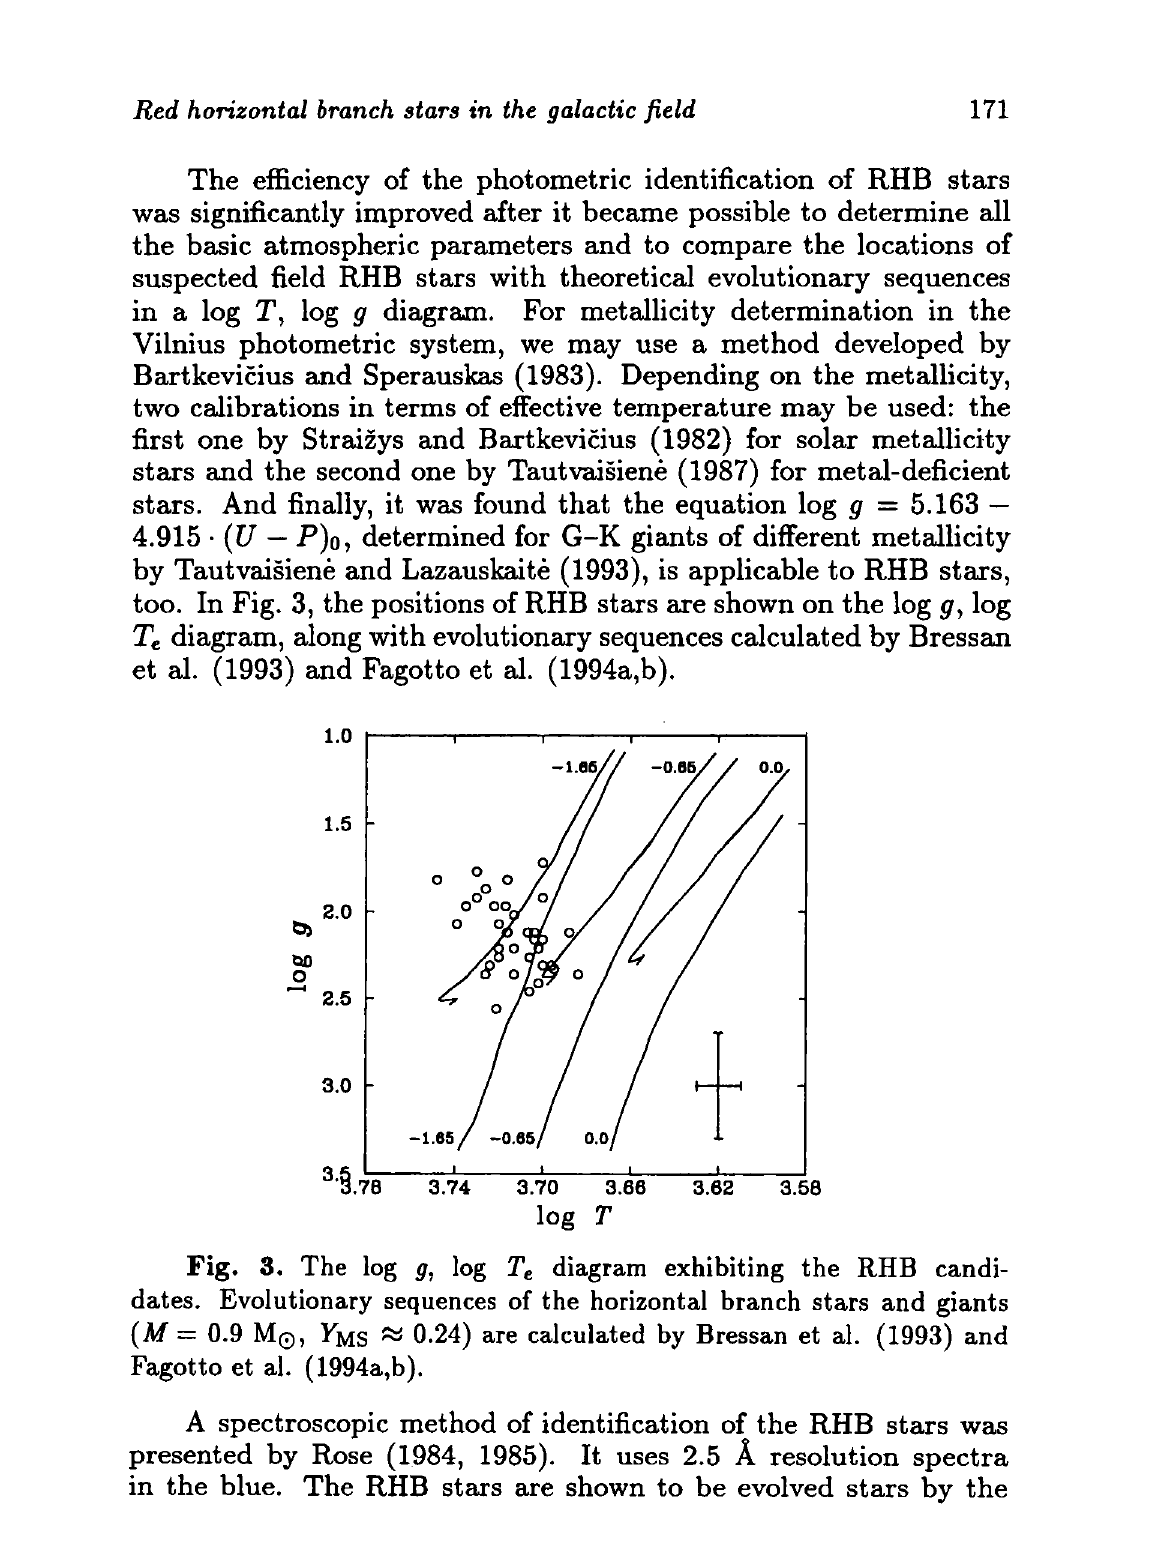
Fig. 3. The log g, log T e diagram exhibiting the RHB candi- dates. Evolutionary sequences of the horizontal branch stars and giants (AF = 0.9 MQ, Y MS « 0.24) are calculated by Bressan et al. (1993) and Fagotto et al. (